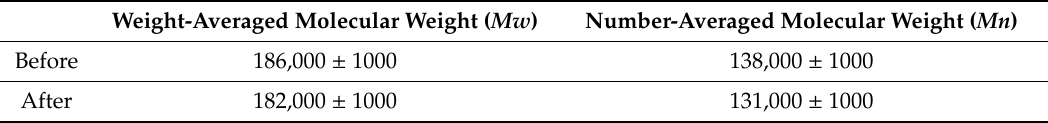
Table 3. Molecular weights of PLLA before and after supercritical treatment.